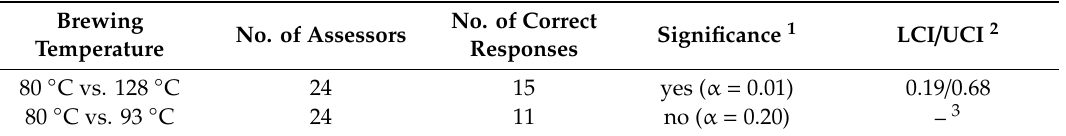
Table 1. Results of the ISO 4120:2004 sensory analysis using triangle testing for di ff erentiation